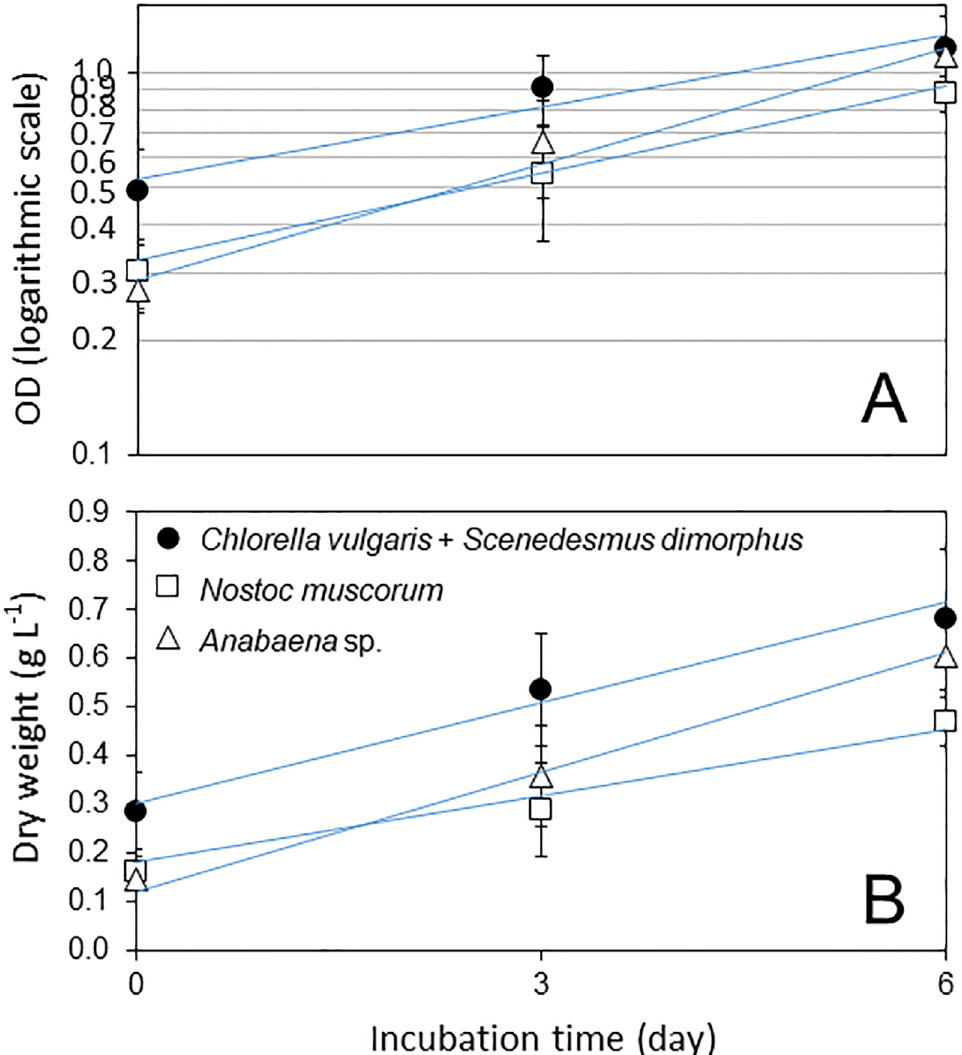
Fig 2. Growth of algae in the 15 L photo bioreactor (PBR). Time-course increase of optical density (OD) at 680 nm wavelength (A) and biomass as dry weight (B) of algae. Mean values from five PBR units with standard deviation are